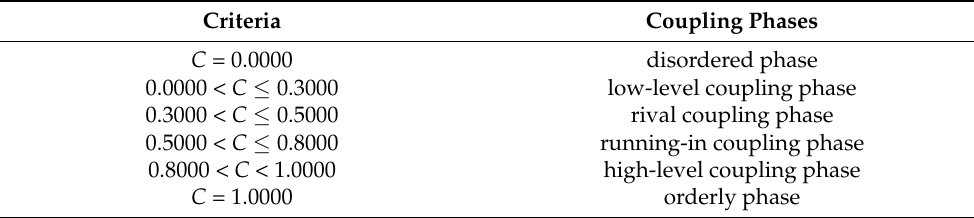
Table 2. Criteria for the coupling phase of the agriculture industry and the tourism